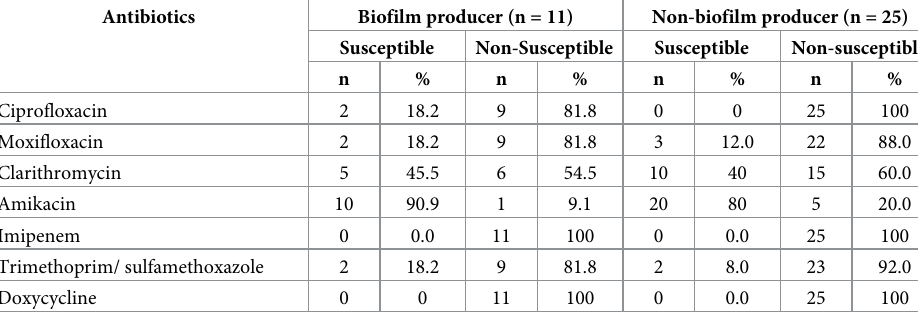
Table 5. Antibiotic susceptibility and biofilm formation in M . abscessus .